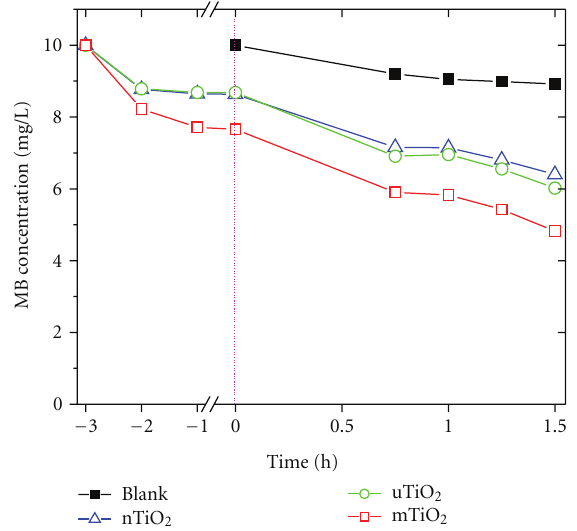
Figure 7: MB adsorption and degradation of the mTiO 2 , nTiO 2 , and uTiO 2 films under UV irradiation. Blank and absorption tests are presented for comparisons.